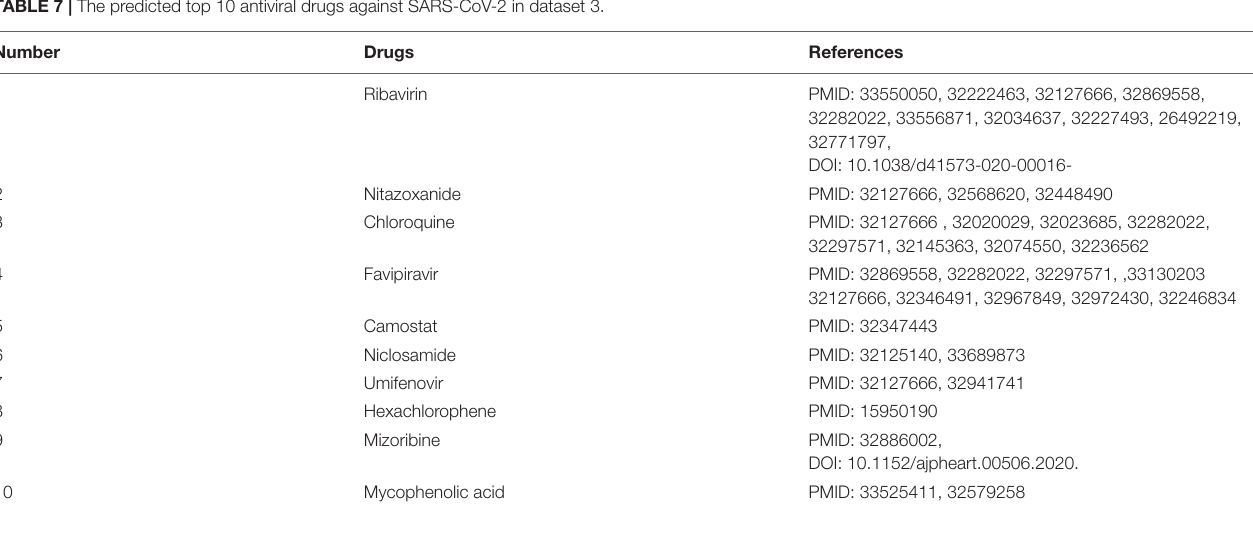
TABLE 7 | The predicted top 10 antiviral drugs against SARS-CoV-2 in dataset